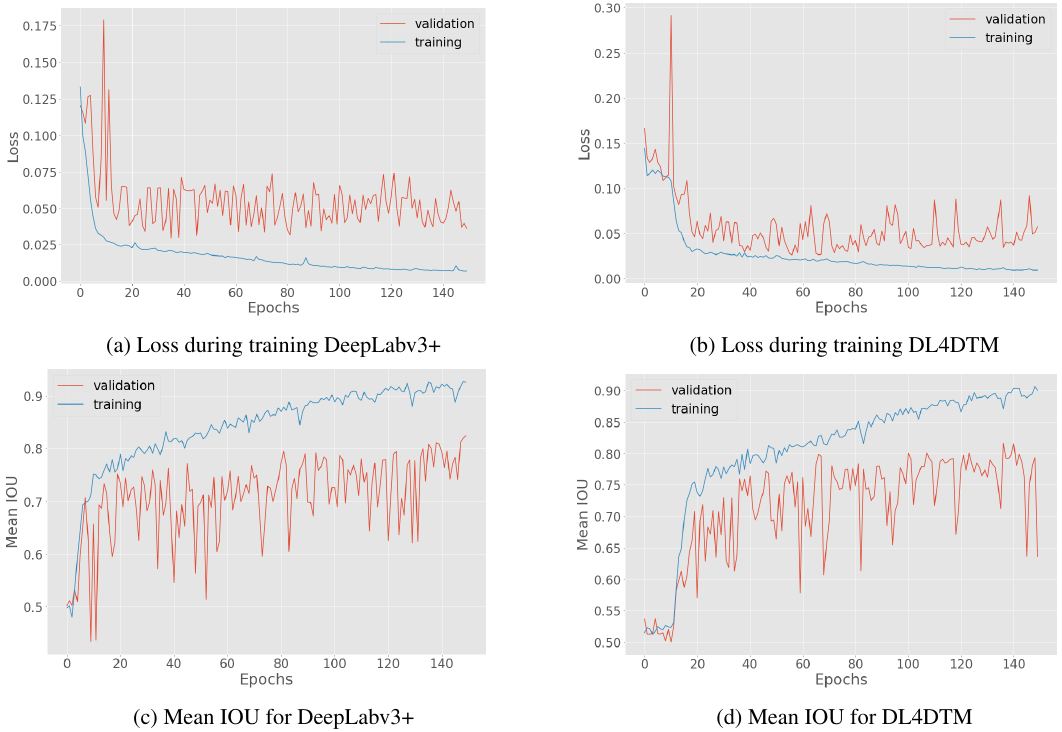
Figure 2. Performance of the DeepLabv3+ and DL4DTM models on our dataset.